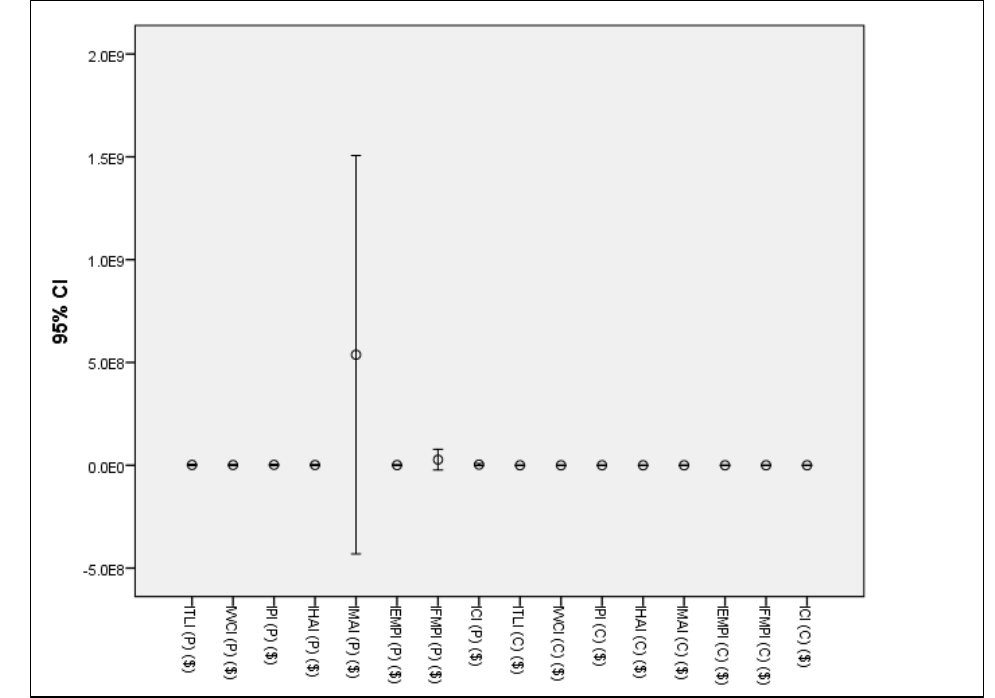
Figure 9: The error bar plot of costs/revenue for industrial